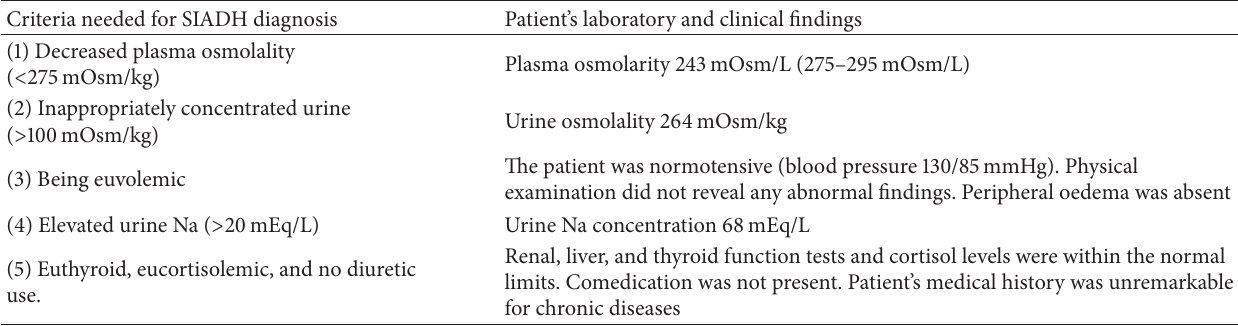
Table 1: The criteria required for the diagnosis of SIADH and the main clinical and laboratory findings of the presented case, which led to the diagnosis of the